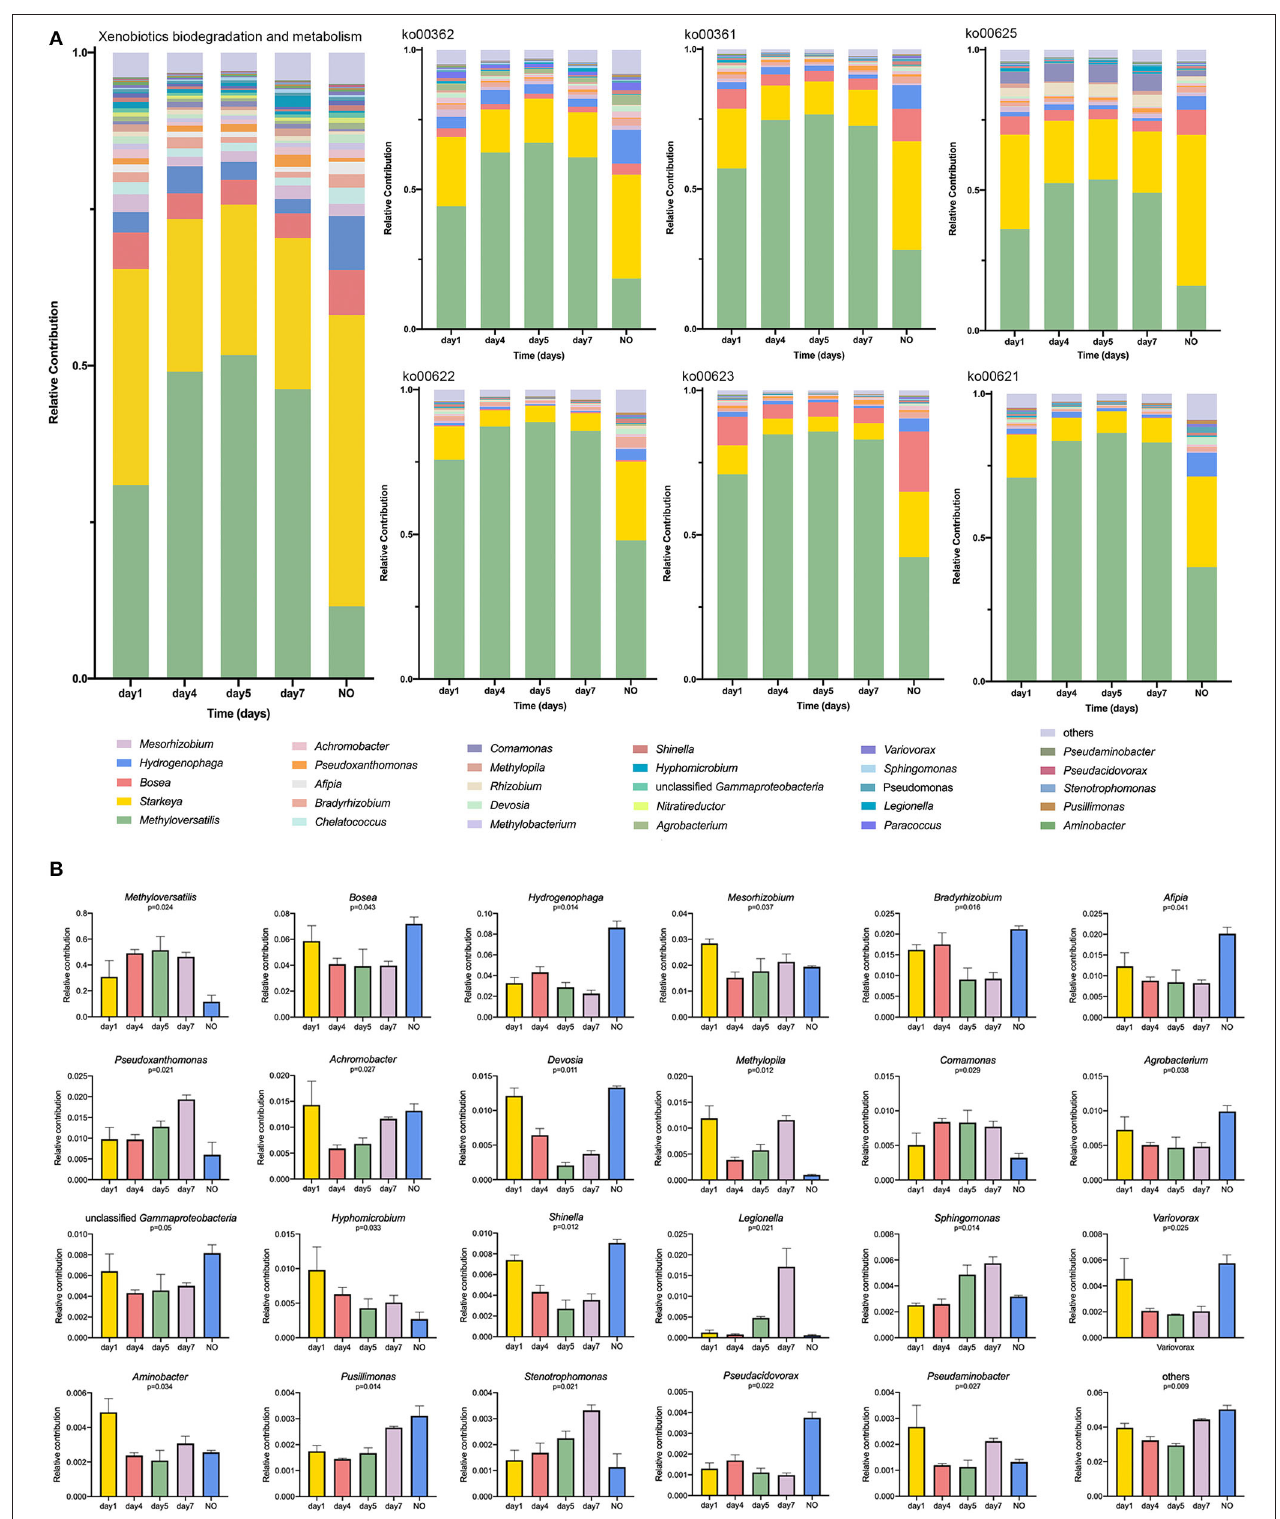
FIGURE 5 | (A) Relative contribution of different taxa at genus level to identified degradation-enriched functional attributes in different groups; (B) The K–W H test at level 3 in the category of “Xenobiotics Biodegradation and Metabolism.”